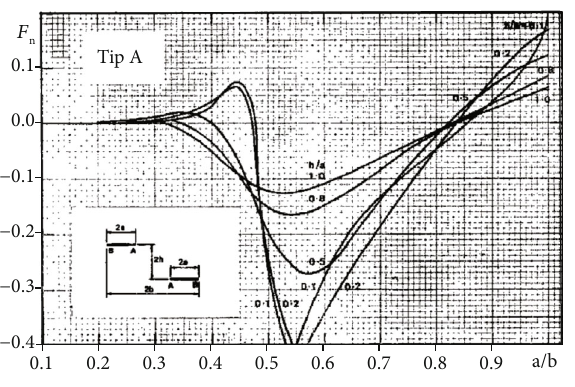
F C 2 ΙΙ and ΙΙ